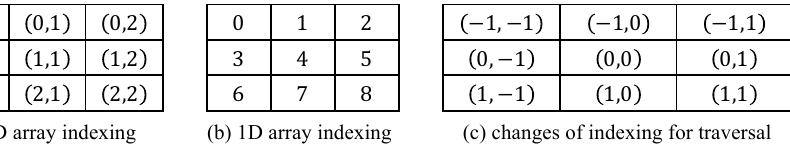
! Fig. 1. Array indexing in one- and